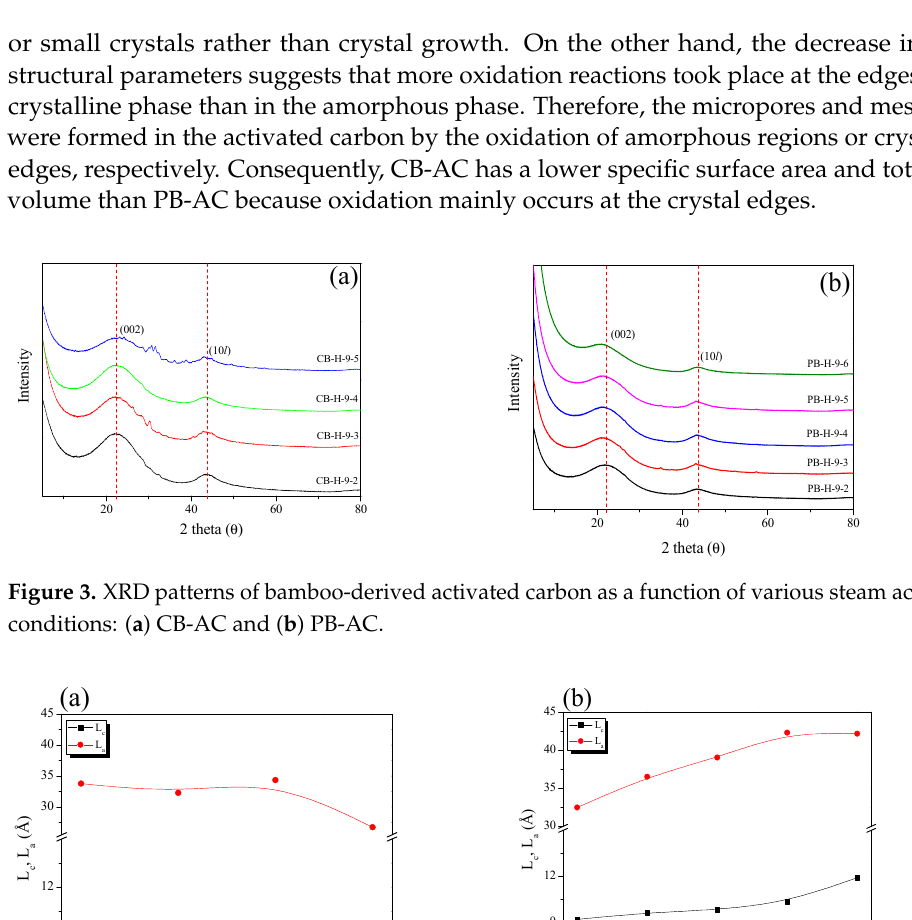
Figure 5. SEM images of the activated carbon electrodes ( a ) PB-H-9-3, ( b ) PB-H-9-4, ( c ) PB-H-9-5, ( d ) PB-H-9-6, and ( e ) YP-50F. The electrochemical properties of the PB-AC electrodes were assessed using GCD, CV, and impedance measurements. The measurements were carried out in 1 M TEABF 4 /PC. Figure 6 shows the GCD curves of the PB-AC electrode at various current densities. The GCD curves of all PB-ACs are linear and symmetrical, which is typical of an ideal EDLC. No obvious IR drop was observed in any of the curves at a current density of 0.1 A/g. However, the IR drop of PB-AC increased with an increase in current density. The IR drop in the GCD represents a voltage change arising from changes in the internal resistance of the electrode, which is related to the self-resistance of the electrode, electro- lyte resistance, distance between the electrodes, and contact resistance between the elec- trode and current collector [6]. Therefore, the IR drop increased owing to the increase in